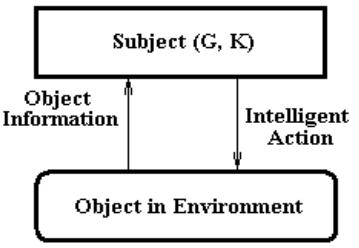
Figure 2. The triadic informational structure “ subject – object- interaction”.